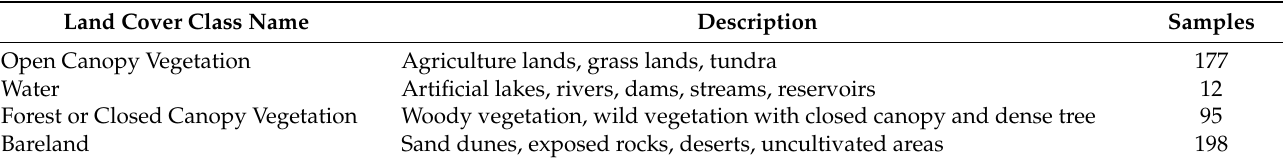
Table 2. Type of classes used for the classifications, and detailed descriptions of what each class covers, with the samples collected for the SVM classification of vegetation in the High Atlas Moun- tains of Morocco.